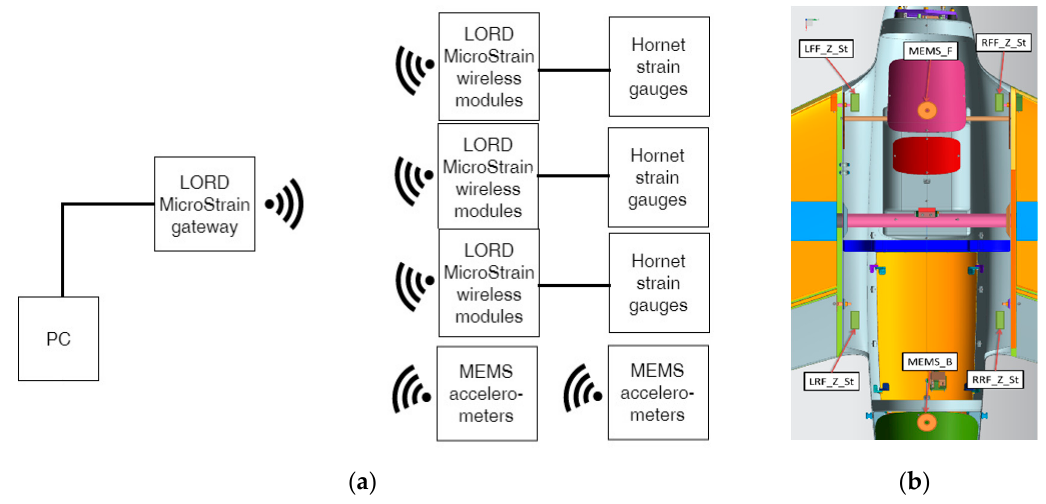
Figure 16. Engine test, ( a ) block diagram of wireless strain and acceleration measurement system, and ( b ) location of MEMS accelerometers on the fuselage.